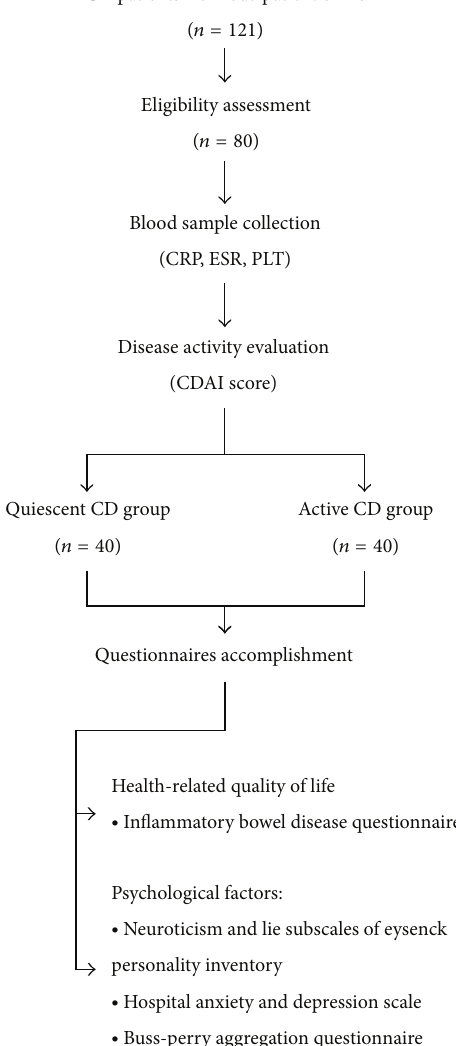
Figure 1: Study design of current prospective study. A total of 121 patients with Crohn’s disease from outpatient clinic were recruited in the current study. After eligibility assessment, 80 eligible patients were enrolled. Their blood samples were collected for CRP, ESR, and PLT analysis. Afterwards, they were evaluated for disease activity with Crohn’s disease activity index (CDAI score) and then divided into quiescent (CDAI ≤ 150 points) and active (CDAI > 150 points) CD groups. All enrolled patients were subsequently required to accomplish HRQoL- related questionnaire (Inflammatory Bowel Disease Questionnaire, IBDQ) and psychological factor-related questionnaires, including Neuroticism and Lie subscale from Eysenck Personality Inventory (EPI), Hospital Anxiety and Depression Scale (HADS), and Buss-Perry Aggregation (BPA) questionnaire. CD: Crohn’s